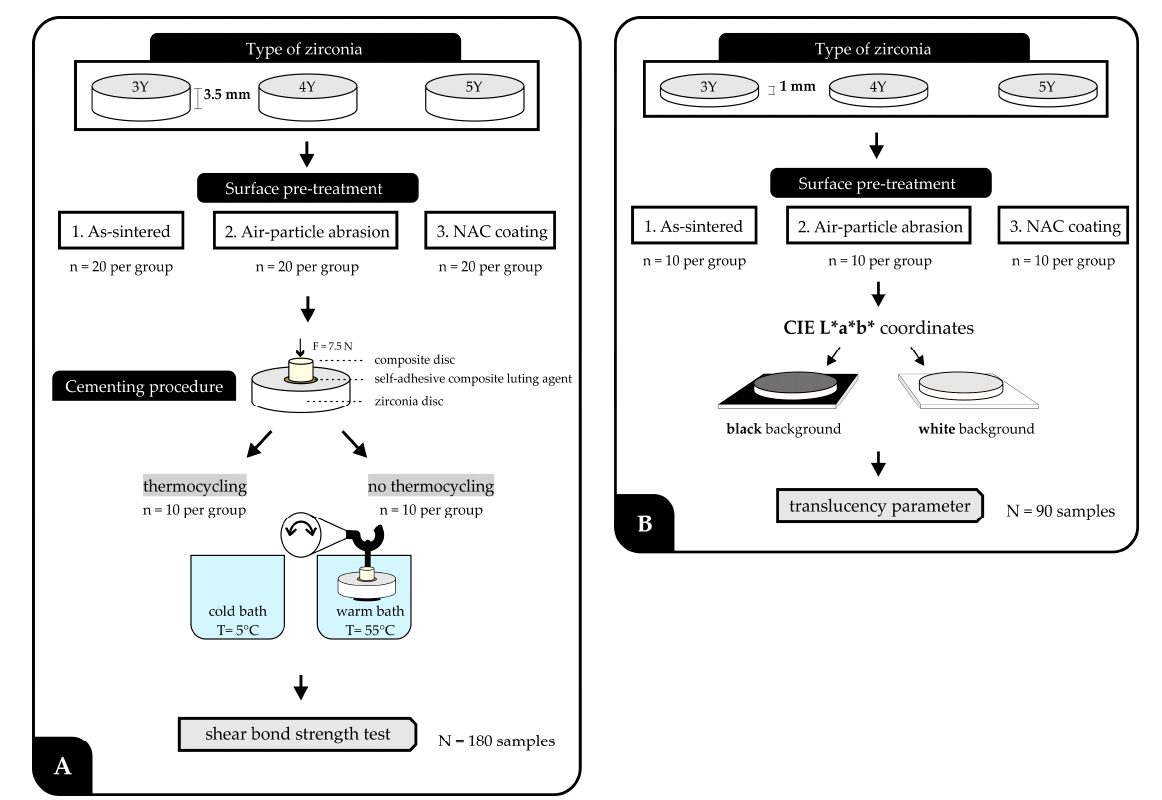
Figure 1. The flowchart of the experimental protocol for the ( A ) shear bond strength test and ( B ) translucency measurements. Group 1: left as-sintered to serve as a control